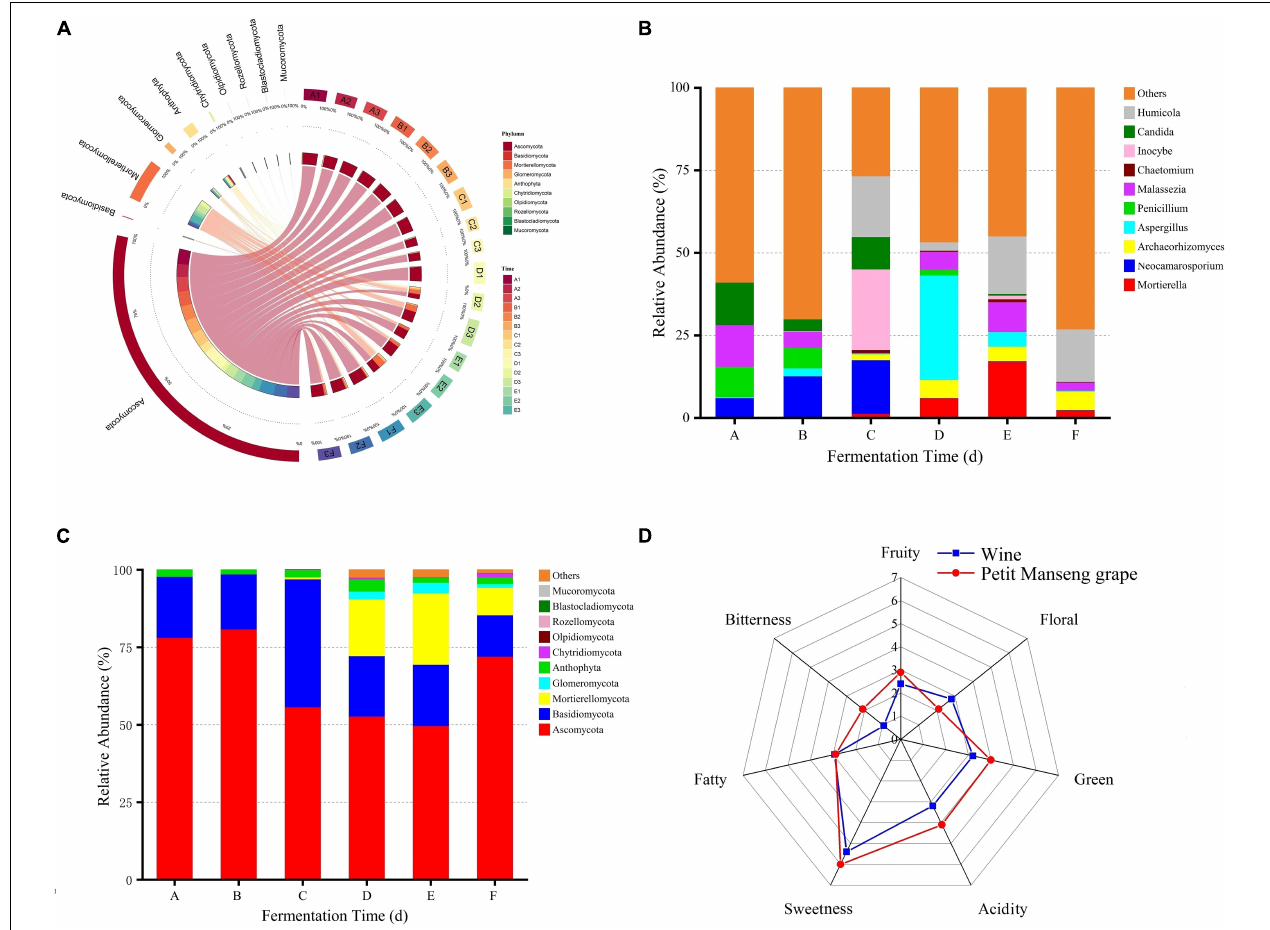
FIGURE 4 | The relative abundance between fungal groups at the phylum (A) level, the relative abundance of the top 10 fungi at the genus (B) level, the relative abundance of top 10 fungi at the phylum (C) level, and sensory analysis of wine samples (D) . A, B, C, D, E, and F represented samples collected on fermentation days 0, 1, 4, 7,11, and 14,